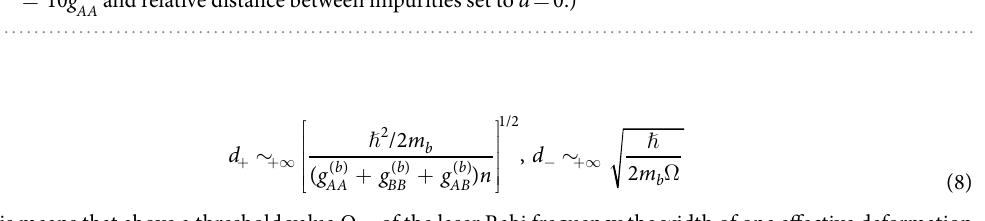
Figure 3. Raman controlled effective deformations of the BEC order parameter: width of the effective healing lengths d j (Ω) = 1/ η j (Ω), normalised for the value in absence of Raman coupling (left). Depth of the effective deformations as a function of the Raman coupling (centre). Contribution of each effective deformation to the system energy Δ E i (Ω), equation (11), in recoil energy units E R (right). The value of the threshold Raman coupling, equation (9) is  Ω .  E 0 61 . (We have assumed the following values: R lim ( ) and relative distance between impurities set to d =